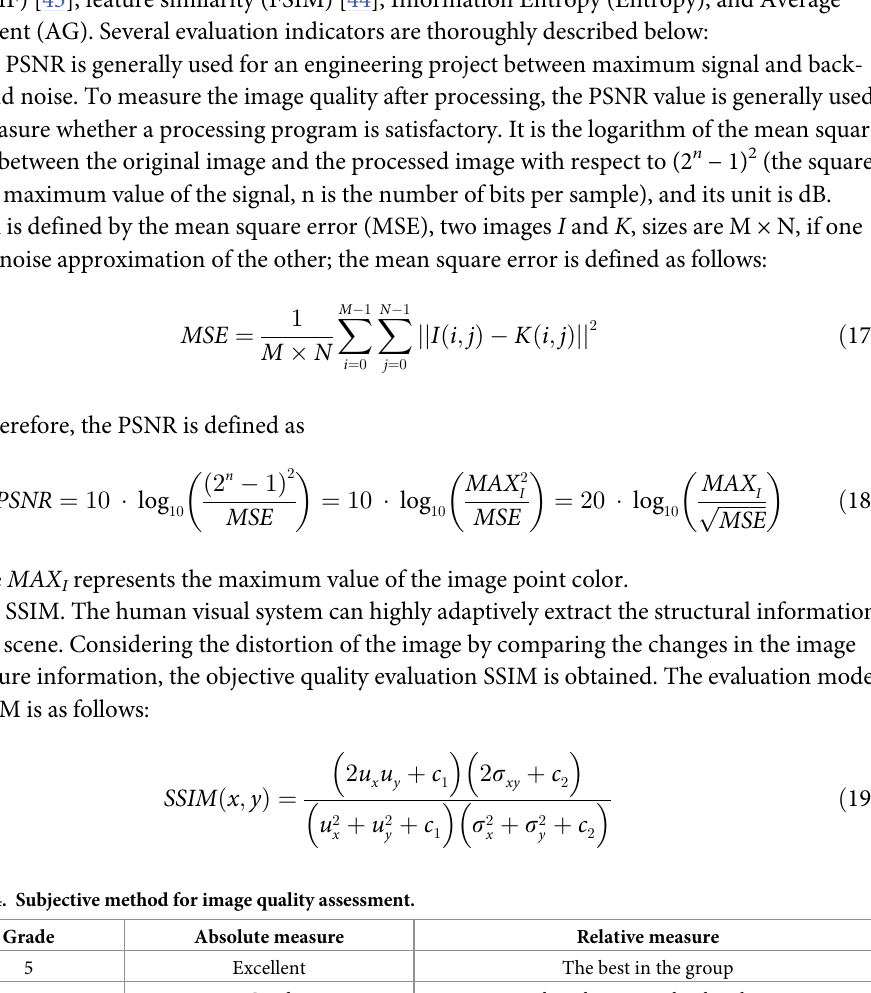
4.2.2 Objective evaluation of image quality. In objective image quality evaluation, the